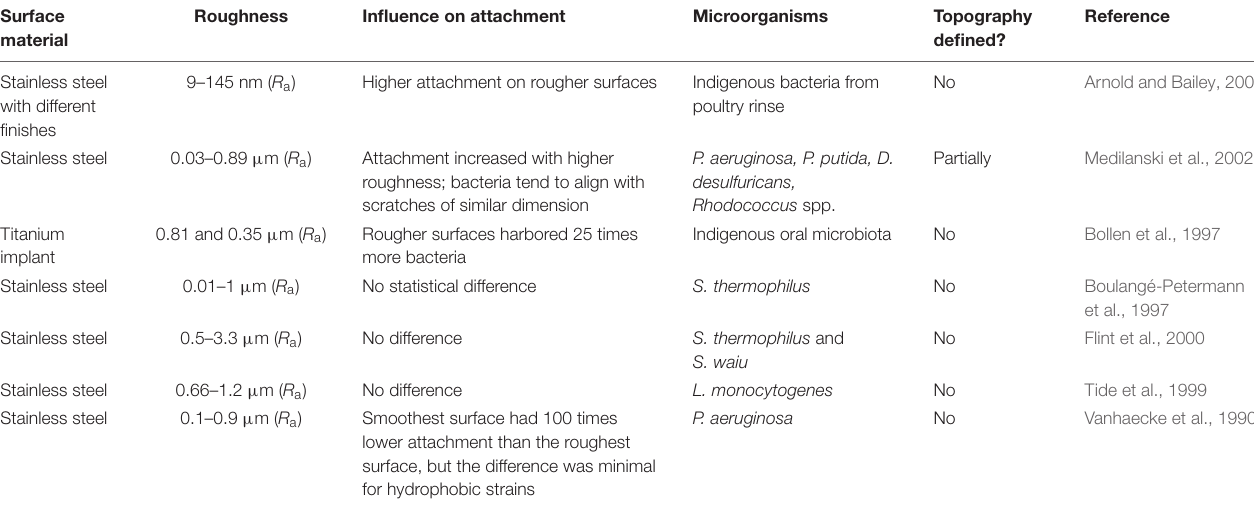
TABLE 2 | Bacterial attachment behavior on surfaces with defined or partly defined topography.